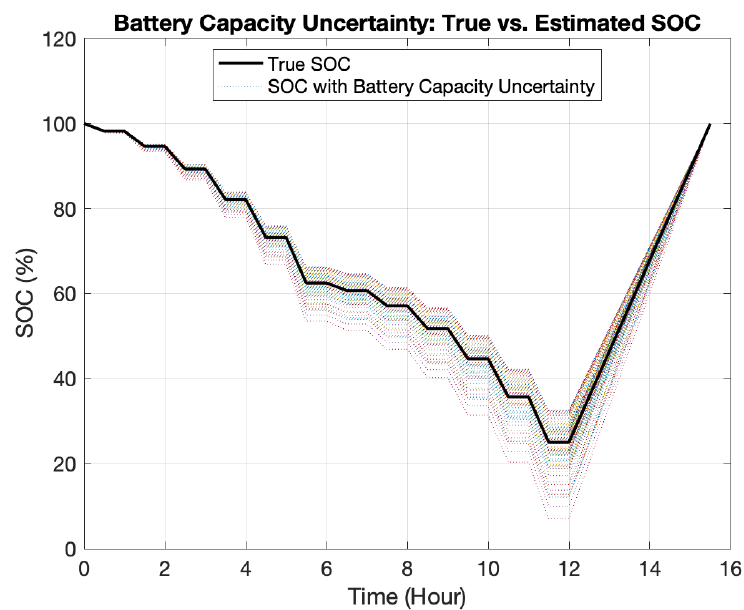
Figure 12. SOC error due to battery capacity uncertainty. This figure shows the difference between the true SOC and the SOC with battery capacity uncertainty for different simulations. The true SOC is computed using the true battery capacity of C true = 1.5 Ah; each Monte Carlo run assumes a different ) . Figure 11 shows all the C battery C batt that is distributed N ( C true , σ 2 batt during different runs. batt